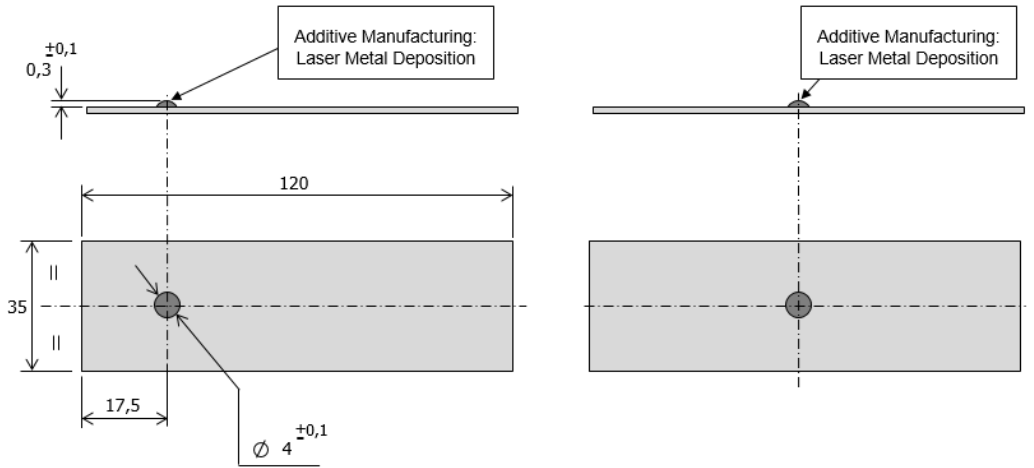
Figure 2. Schematic drawing of the specimens for the execution of the laser deposition (additive manufacturing) using metal powder, for both tensile tests and cross-tension tests,